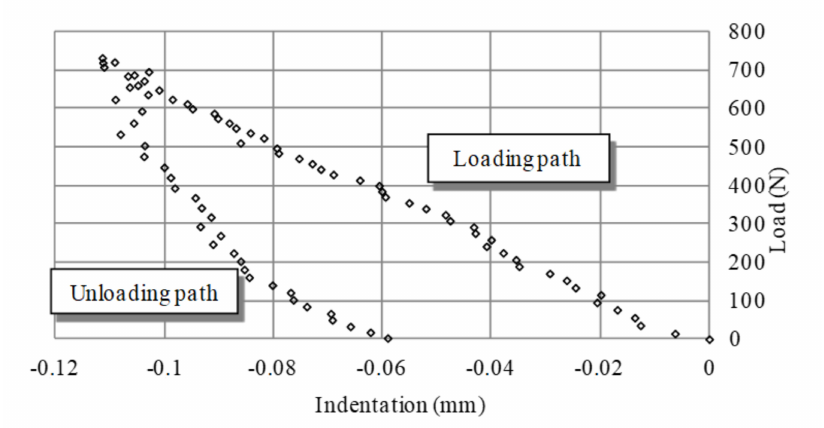
Figure 7. Experimental contact force for a 2 mm thick specimen.